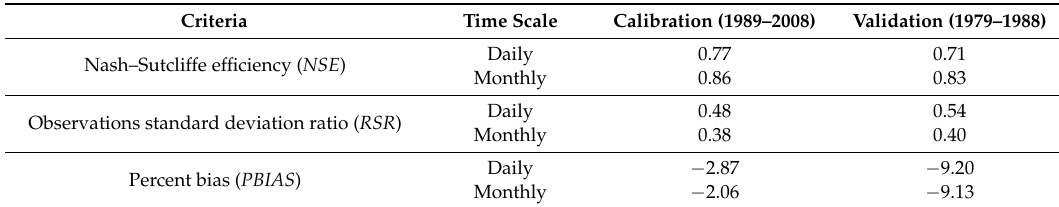
Figure 6. Time series of monthly observed and reproduced streamflow for the upper Thu Bon River basin at Nong Son in the period of 1979–2008. Table 2. Super-tank model performance statistics.